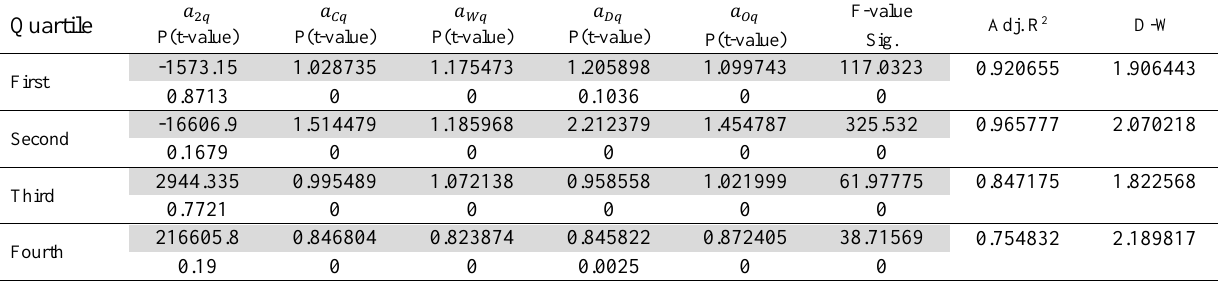
The summary of testing the second hypothesis when the data are arranged according to